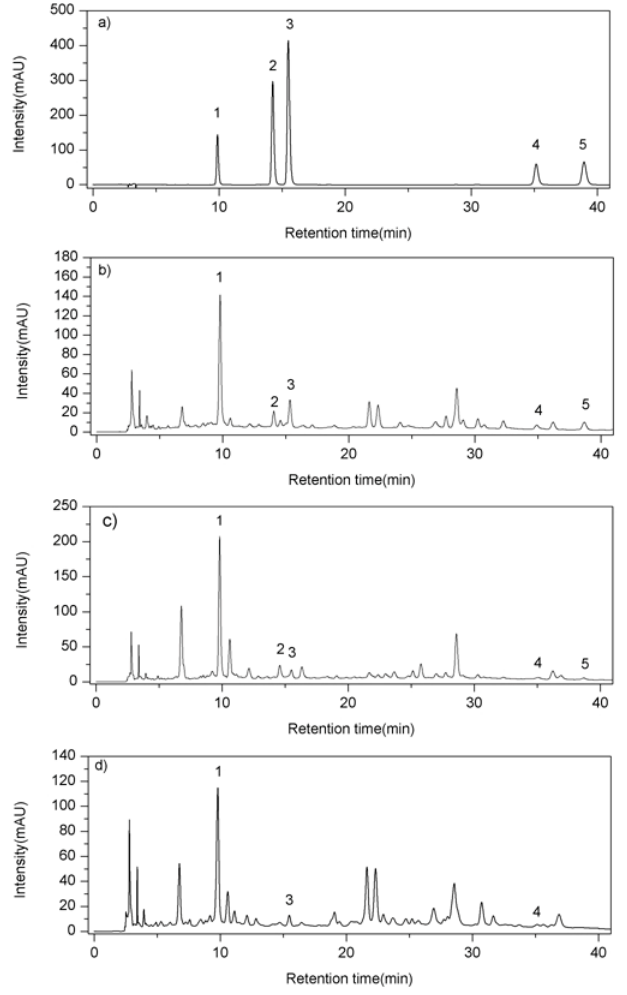
Figure 4. HPLC chromatograms of ( a ) standard mixture; ( b ) Pyrrosiasheareri ; ( c ) P. lingua ; ( d ) P. petiolosa . ( 1 . chlorogenic acid; 2 . mangiferin; 3 . isomangiferin; 4 . trifolin; 5 . astragalin).